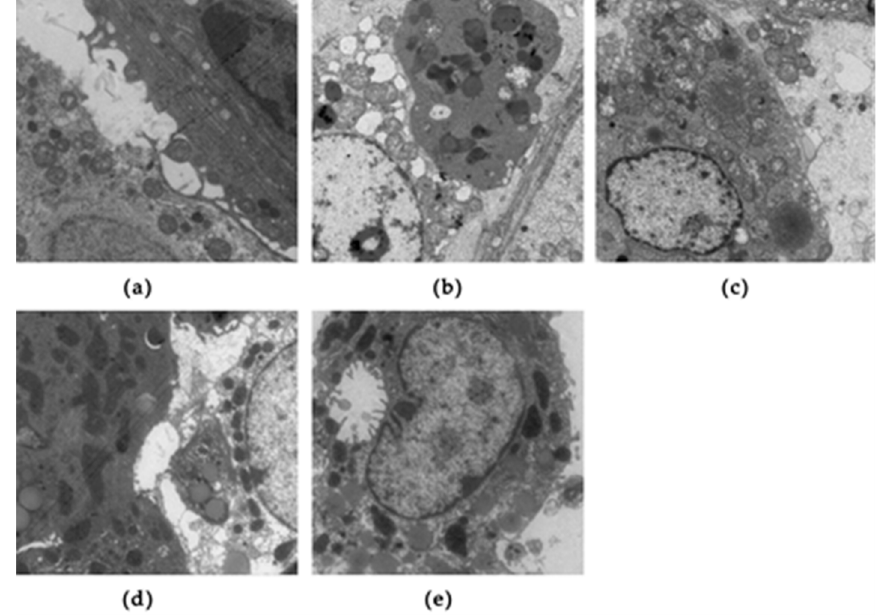
Figure 5. Effects of SFN on the morphology of testis in obese mice: Electron microscopy images display the control group ( a ), DIO group ( b ), DIO + SFN 5 mg/kg group ( c ), DIO + SFN 10 mg/kg group ( d ), and DIO + SFN 20 mg/kg group ( e ).